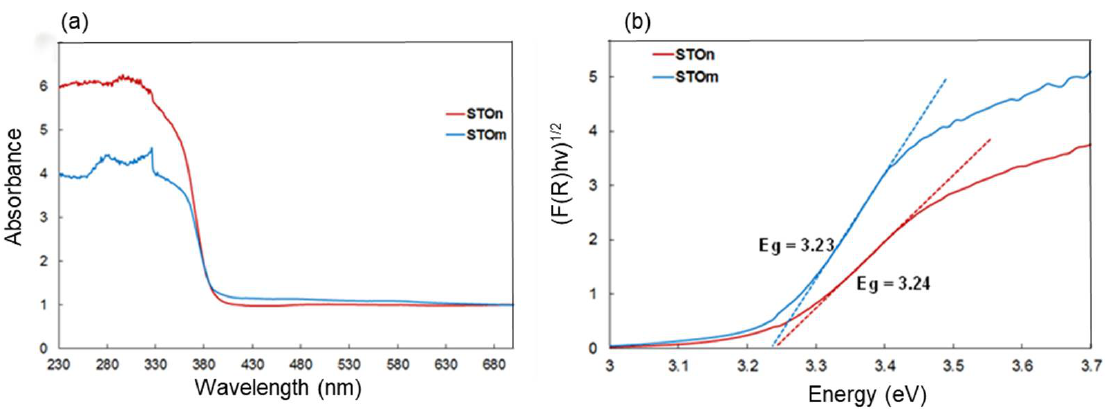
Figure 5. UV–visible absorption spectra ( a ) and Tauc plots ( b ) for STOm (blue line) and STOn (red line).